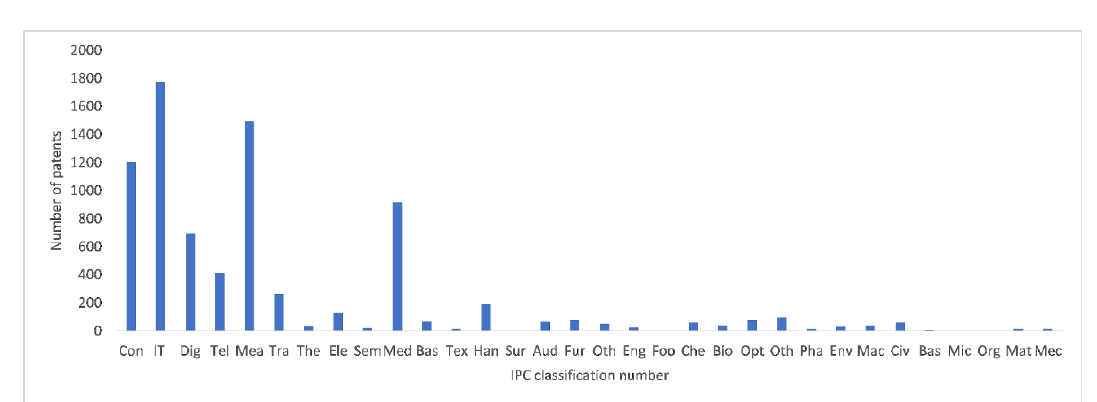
Fig. 4 Quantity of AI patents in different fields.